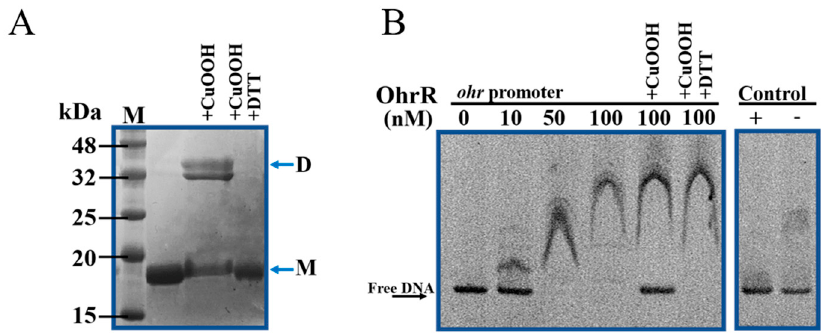
Figure 4. OhrR binds with high affinity to the promoter region of ohr . ( A ) Purified OhrR treated with CuOOH or DTT was analyzed by non-reducing SDS-PAGE. The monomeric (M) and dimeric (D) form of OhrR are indicated by arrows. ( B ) EMSA was performed to detect the interaction of OhrR with the ohr promoter. DNA fragment containing the promoter region of ohr was incubated